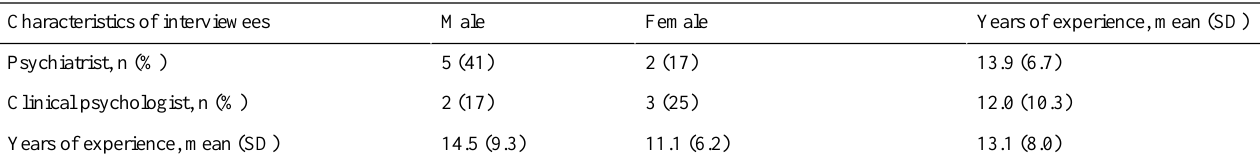
Table 1. Participant